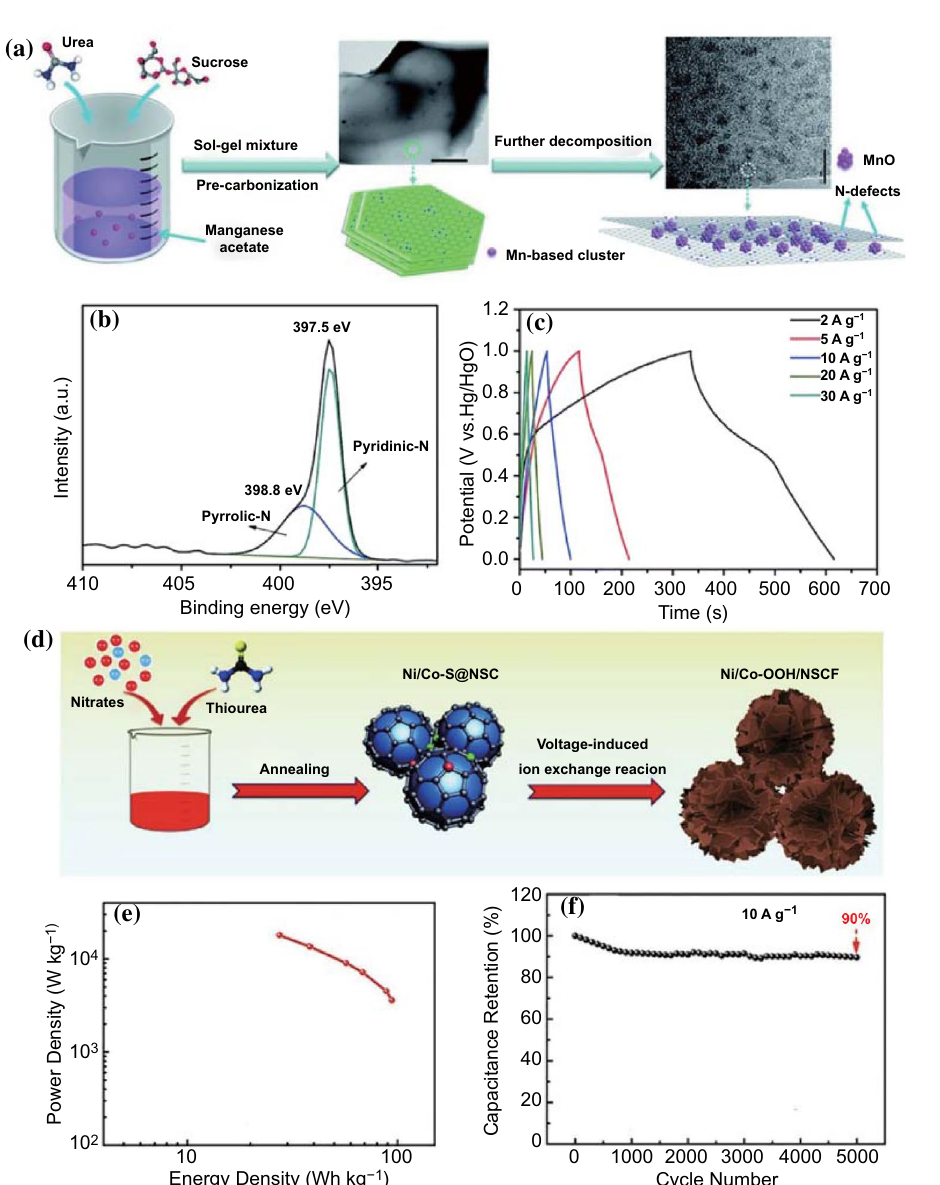
Fig. 8 a Synthetic procedure picture of MnO@NCs. b High-resolution XPS of N 1 s peak of MnO@NCs. c Galvanostatic charge–discharge curves MnO@NCs of concerning current densities. Adapted with permission from Ref. [86] Copyright 2014 Royal Society of Chemistry. d – f Schematic illustration for the synthesis and Ragone plots, cycling performance of Ni/Co–OOH/NSCF. Adapted with permission from Ref. [17] Copyright 2020